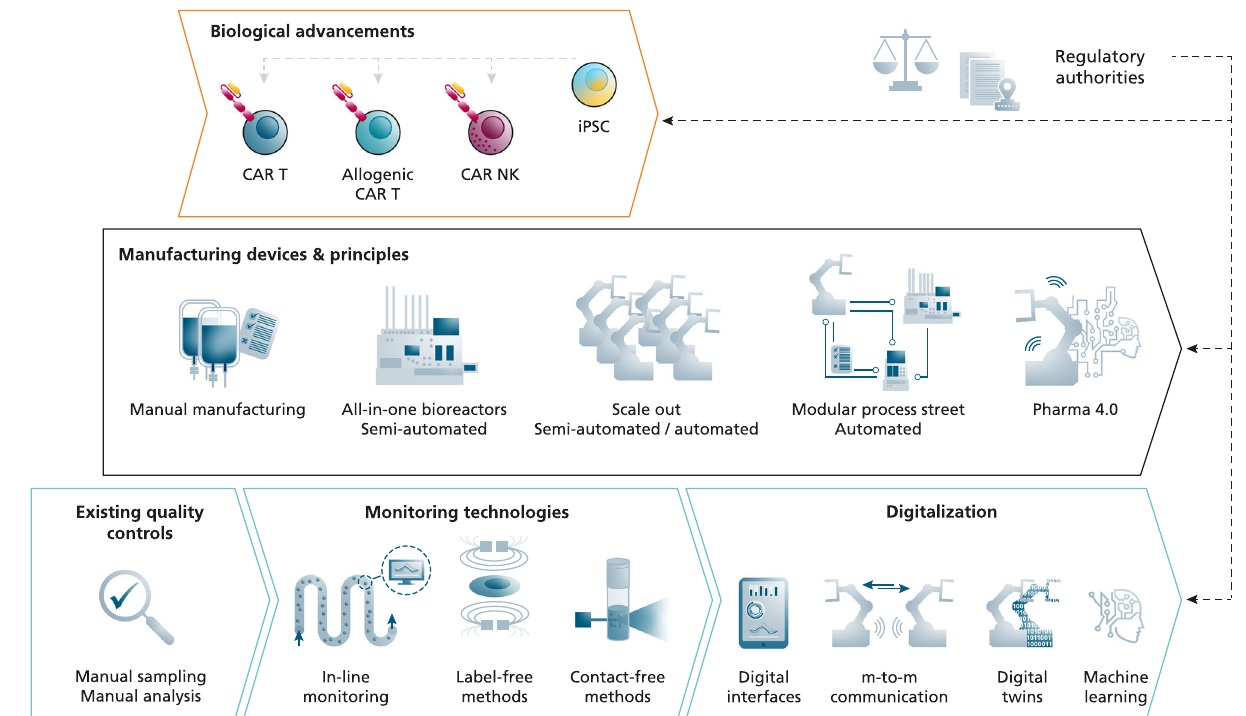
Fig. 2 | Technological innovations for automated cell manufacturing. Novel manufacturing devices and principles to enable automated CAR cell production. CAR T cells are often produced manually but fi rst semi-automated all-in-one bior- eactors are available for the GMP compliant cell manufacturing. For a high- throughput production of autologous products, one solution is using parallelized manufacturing devices. Another principle is connecting different manufacturing devices performing speci fi c sub-processes of the CAR cell manufacturing